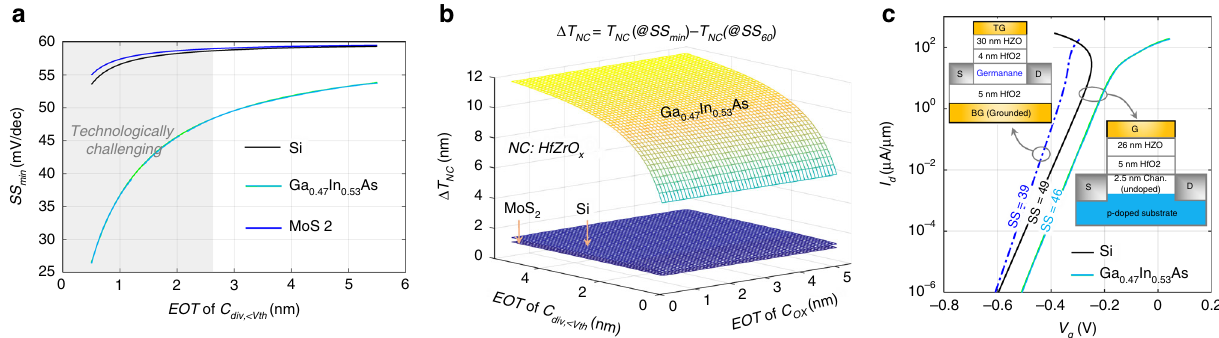
Fig. 3 Impact of density-of-states on SS min and NC design space. a SS min at room temperature and b NC thickness design space ( Δ T NC ) for Si, Ga 0.47 In 0.53 As, and monolayer MoS 2 . The effective DOS (conduction band) of Si and Ga 0.47 In 0.53 As are ~2.8 × 10 19 cm − 3 and ~2.1 × 10 17 cm − 3 , respectively. The DOS of single-layer MoS 2 is ~2.4 × 10 14 eV − 1 ·cm − 2 . The low- DOS Ga 0.47 In 0.53 As exhibits signi fi cant advantages. C div,<Vth and C OX are normalized w.r.t the equivalent oxide thickness (EOT). c With the same device structure/size, Ga 0.47 In 0.53 As device can (in principle) achieve smaller SS , w.r.t. Si device, without hysteresis. SS of monolayer Germanane device can reach 39 mV per decade due to its low-DOS. The DOS of single-layer Germanane is ~2.9 × 10 13 eV − 1 ·cm −